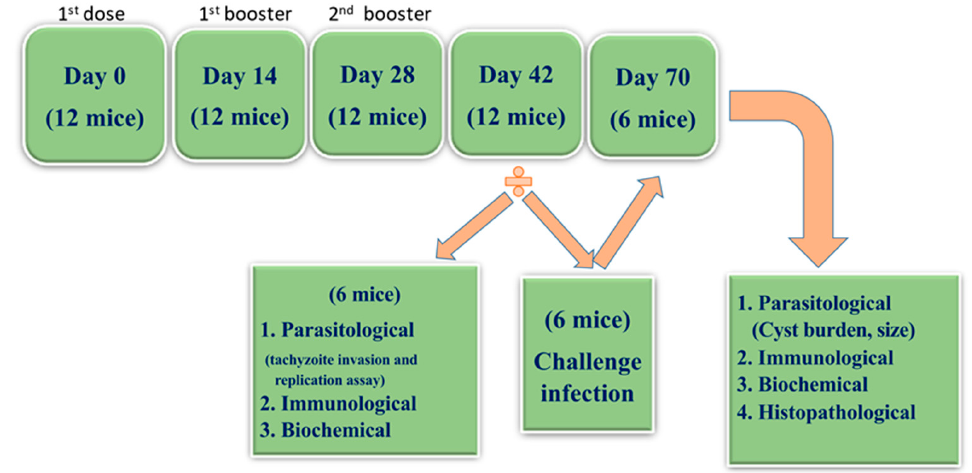
Figure 1. Flowchart representing the time schedule of the experimental study. The remaining mice were infected two weeks after the second booster dose by gavage, with 100 µ L of the brain homogenate containing 20 cysts of Me49 Toxoplasma strain (non- lethal dose) [30]. Four weeks following the challenge of the infection, mice from each group were anesthetized and sacrificed as previously mentioned. Serum, intestinal segments, brains, and spleens were collected for subsequent studies (Figure 1).